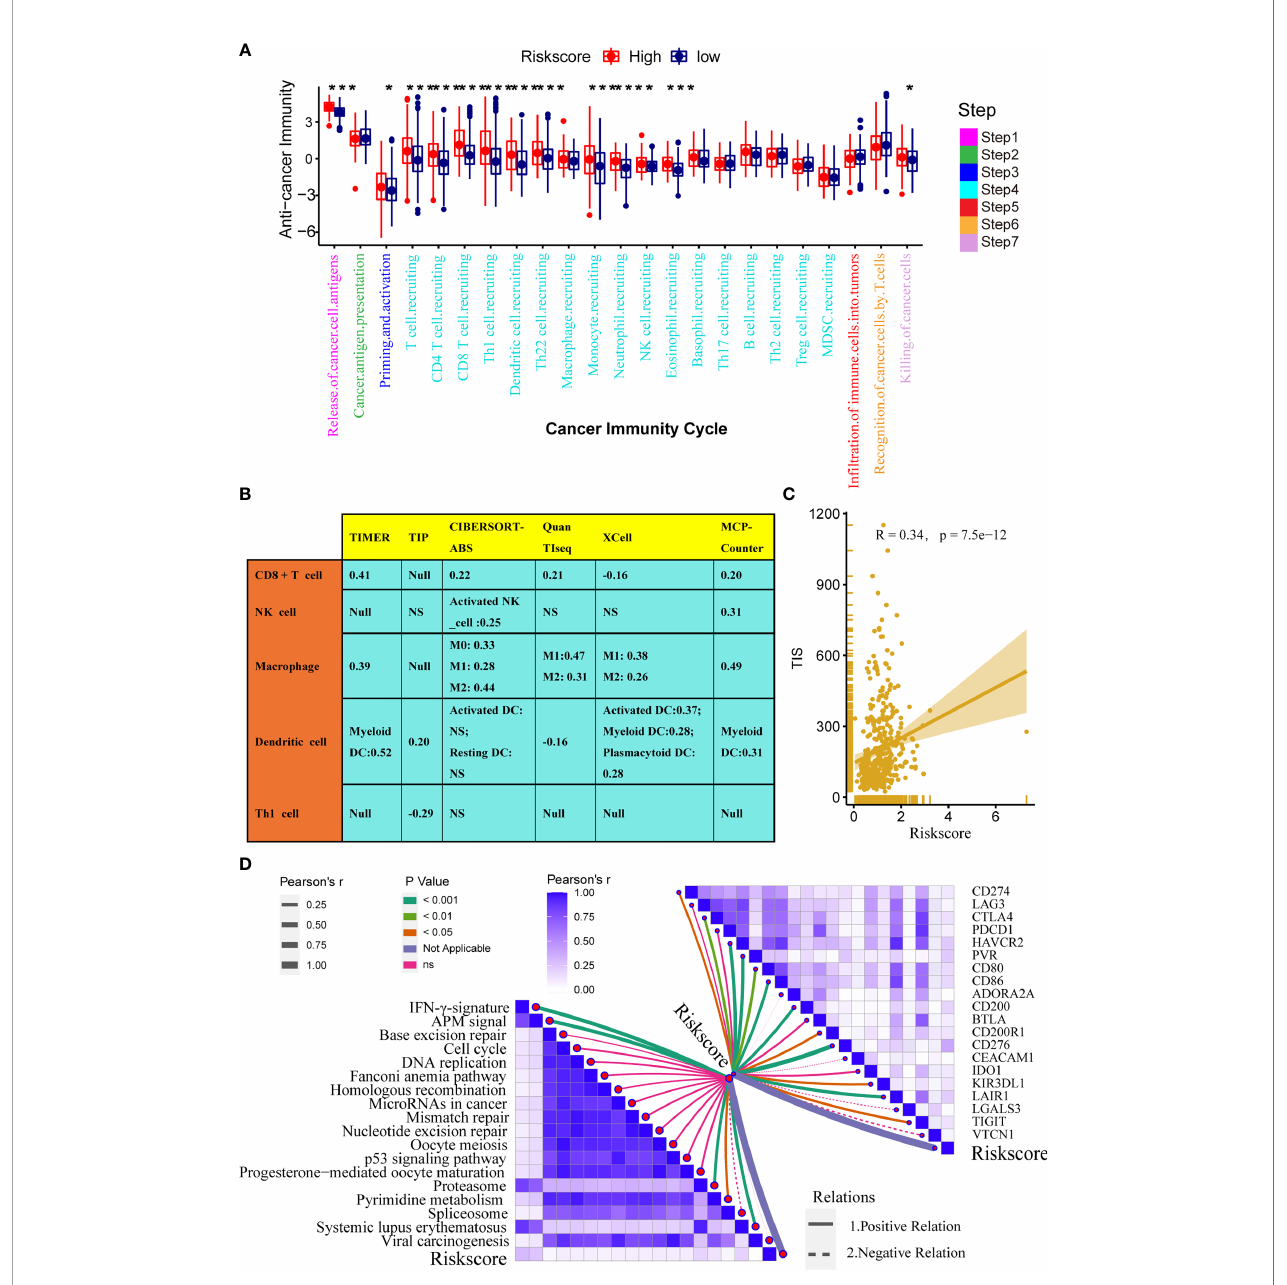
FIGURE 4 | Relationships between the TGF- b risk score and the tumour immune microenvironment characteristics. (A) Differences between the high- and low-risk score groups with respect to the activities of the cancer immunity cycles. (B) Relationships between the TGF- b risk score and the levels of several critical TIICs (CD8+ T cells, NK cells, macrophages, Th1 cells, and DCs) in six independent algorithms (right panel). (C) Relationships between the TGF- b risk score and the T cell in fl amed score (TIS). (D) Relationships between the TGF- b risk score and the enrichment of ICB response related pathways (left panel), and relationships between the TGF- b risk score and immune checkpoints (right panel). (*P < 0.05; **P < 0.01; ***P < 0.001; NS, not signi fi